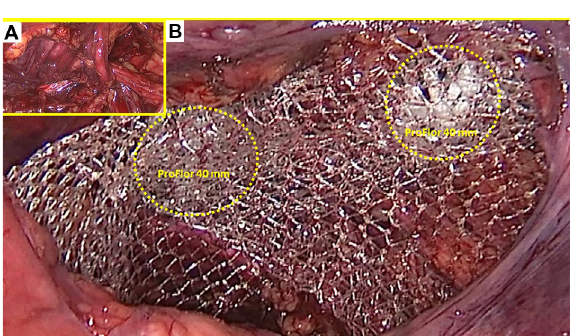
Figure 6. ( A ) preperitoneal aspect of a right sided groin showing two large ipsilateral hernias composed by one direct the medial inguinal fossa and one indirect in the lateral fossa. ( B ) a couple of 40 mm ProFlor E have